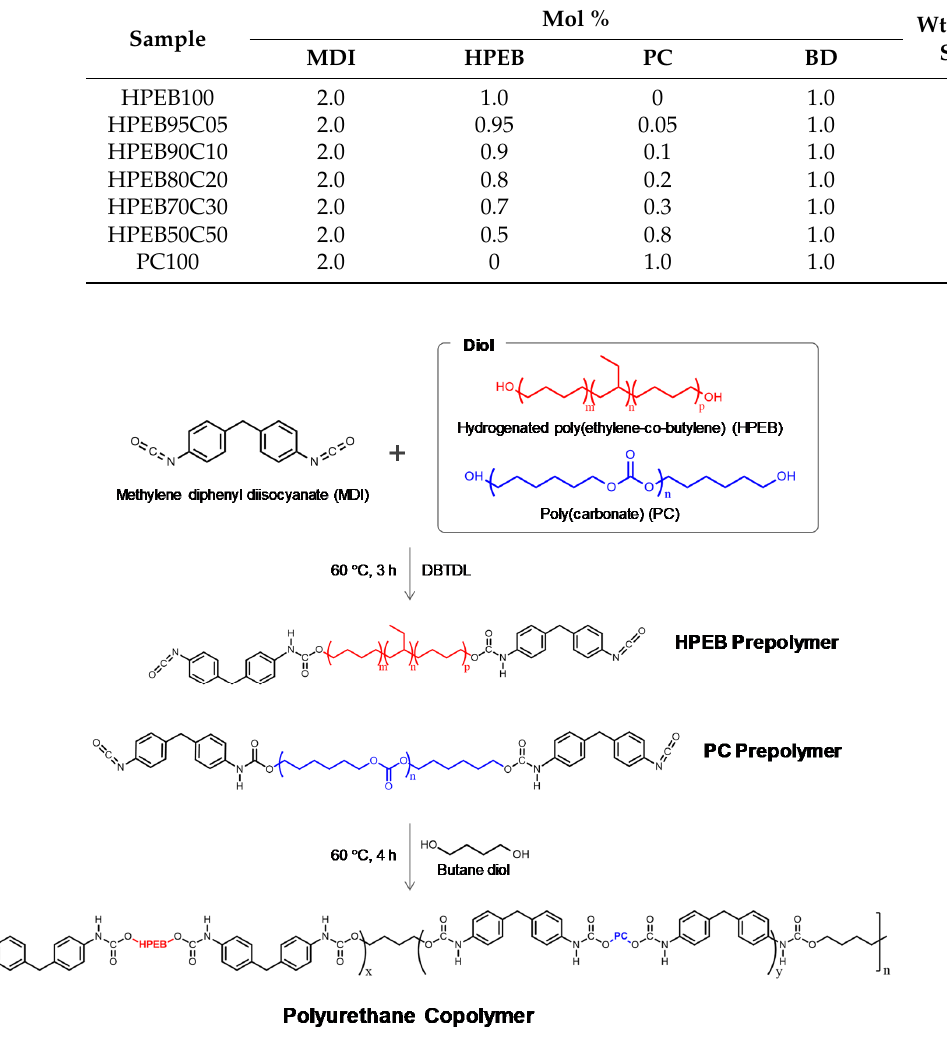
Table 1. Molar feed ratio of reactants for the polyurethane copolymerization.